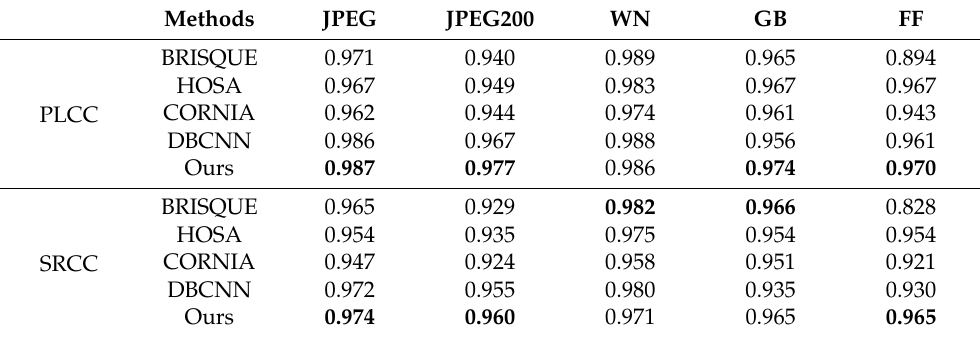
Table 3. Average PLCC and SRCC results of individual distortion types on the LIVE databases. The top-performing method is highlighted in